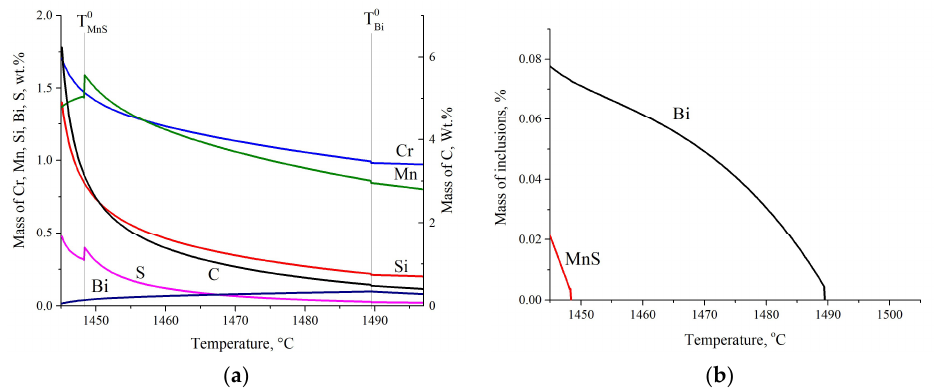
Figure 3. The dependence of the content of alloying elements in steel 0.4C-Cr + 0.08Bi ( a ) and the amount of formed bismuth and manganese sulfide (MnS) ( b ) on temperature.